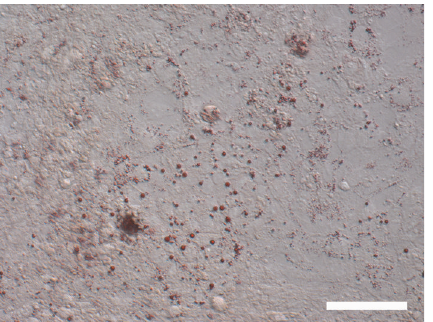
Figure6:OilRedOstainingofpigLCsaftercultured7dinthebasic medium (bar = 50 𝜇